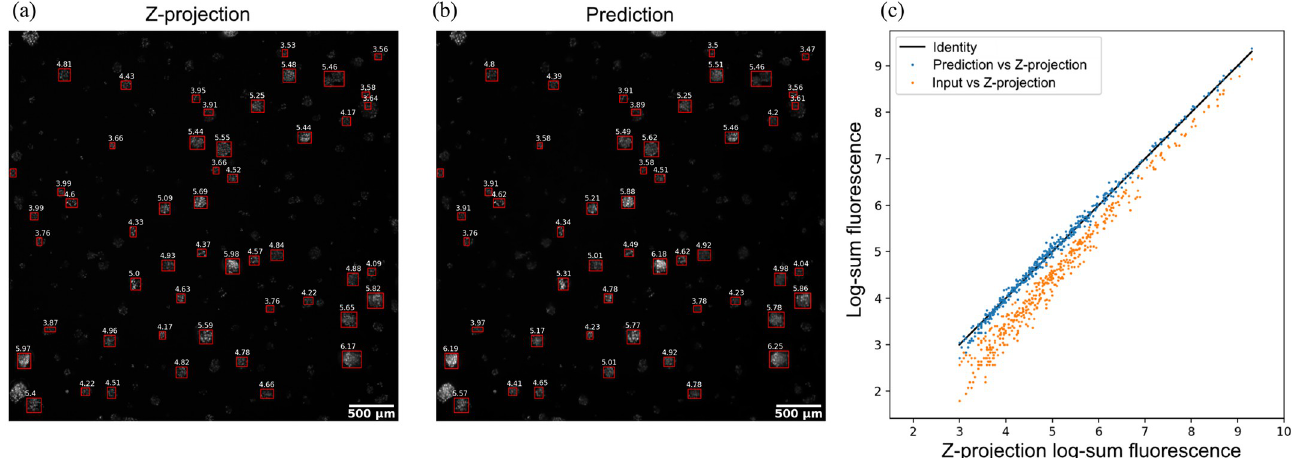
Fig 7. Comparison of mean fluorescence intensity measurements of tumor spheroids shows fidelity between ground true and predicted z-projection images. Representative example of (a) true z-projection and (b) OSA-CGAN predicted z-projection image, with mean intensity values overlaid for each tumor spheroid. (c) Logscale scatterplot of mean intensity values of predicted vs. ground truth (blue) and predicted vs. input z-sweep images (orange).